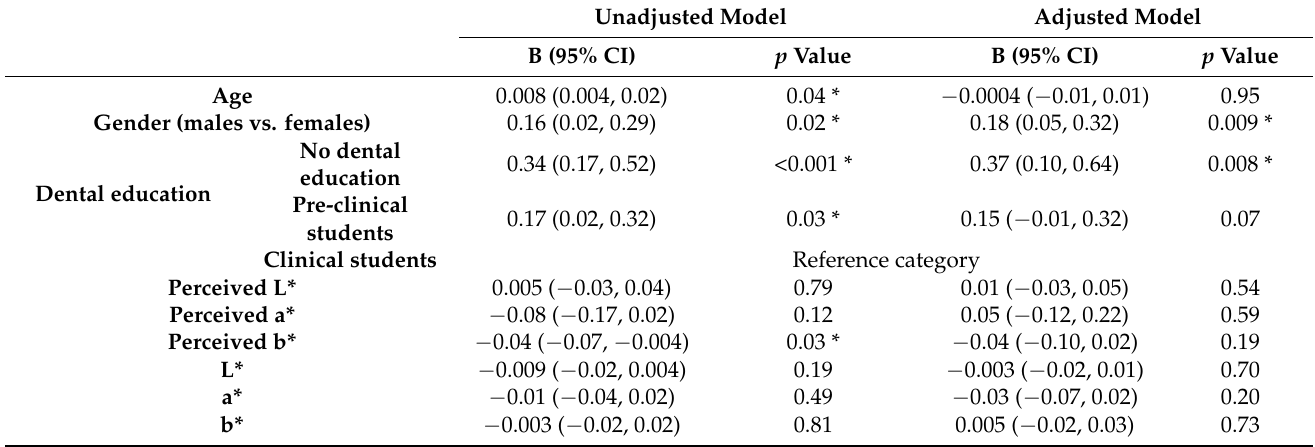
Table 3. Association between dental esthetic attitude, background factors, and self-perceived tooth